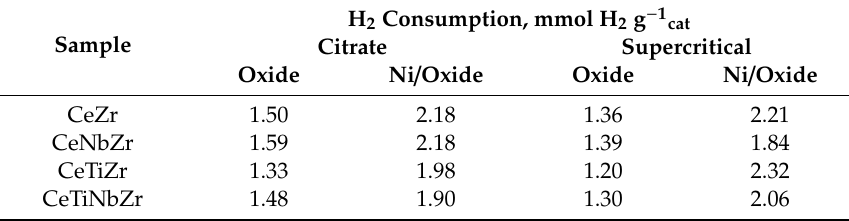
Table 5. H 2 consumption during the temperature programmed reduction for supports and catalysts.